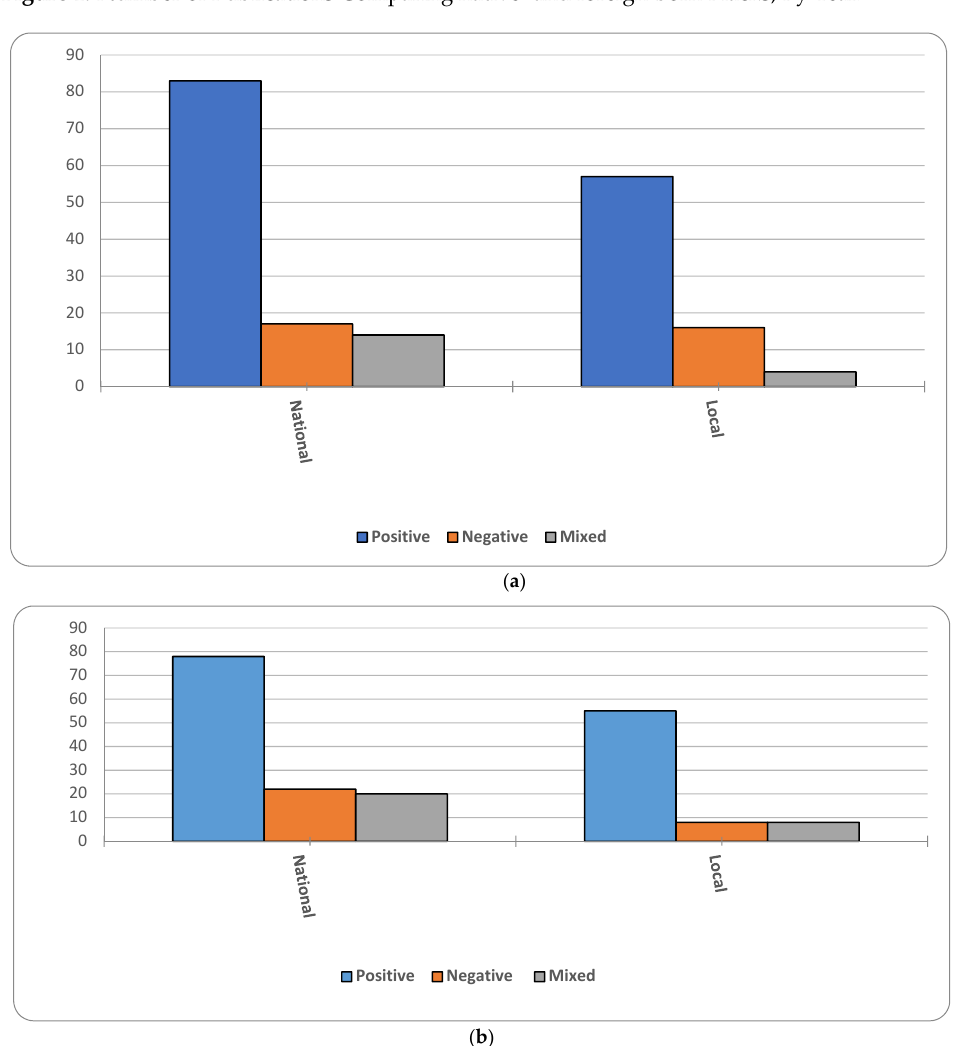
Figure 2. ( a ); Proportion of studies affirming hypothesis, Bivariate results ( b ) Proportion of studies affirming hypothesis, Multivariate